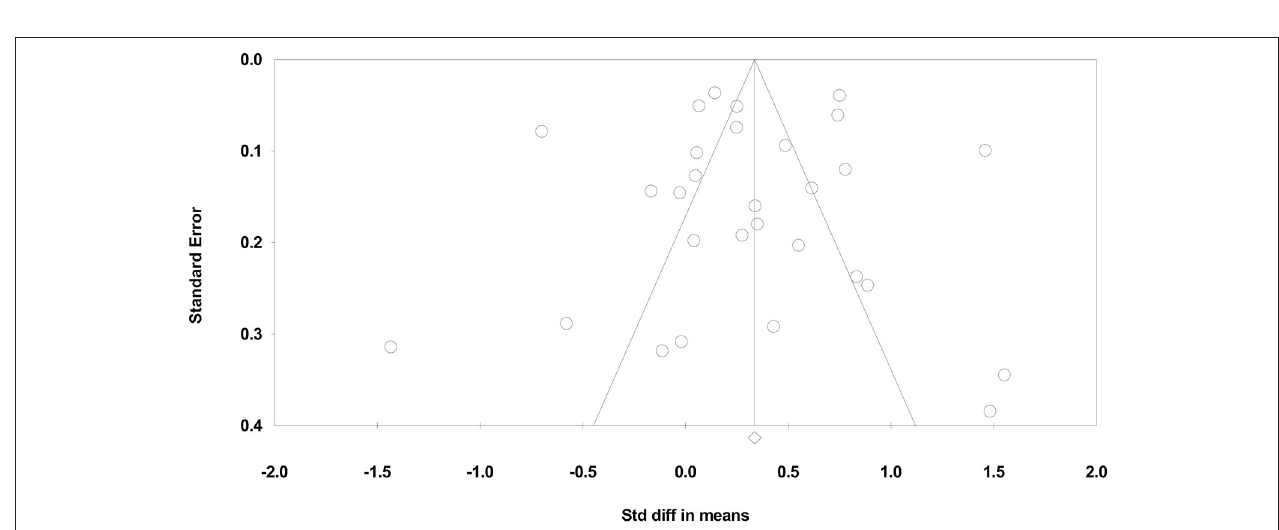
FIGURE 5 | Forrest plot of standardized difference in means of social PE interventions.